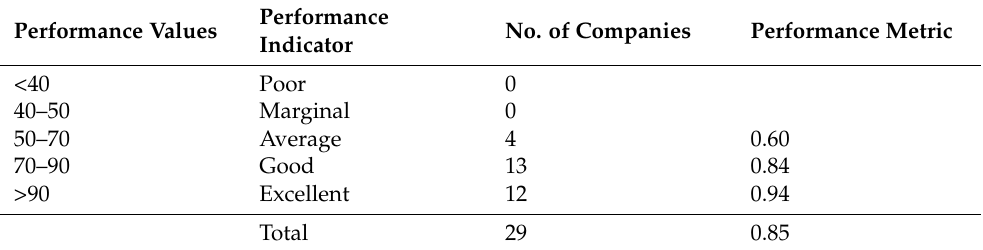
Table 10. Summary of the SC performance metrics for the 29 companies that answered the survey. Performance